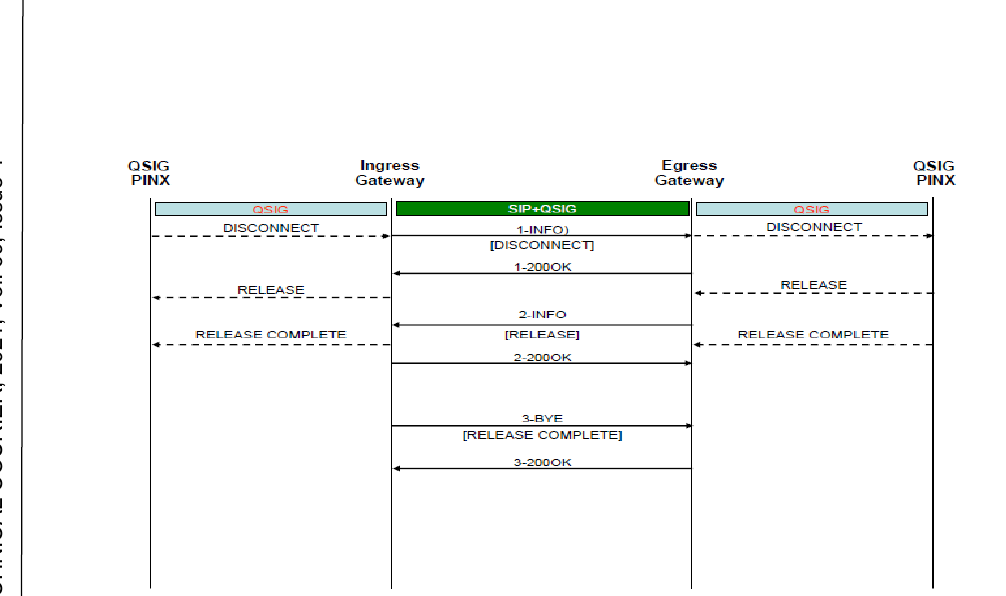
Figure 4 – Termination of a Q-SIG call from Q-SIG, via the SIP, to Q-SIG (Ecma International,